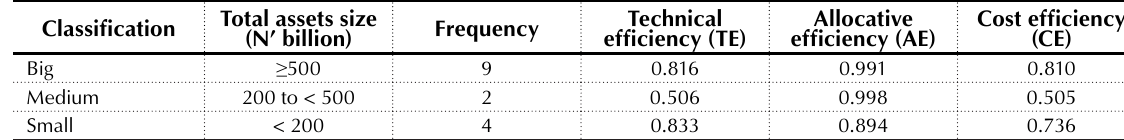
Source: authors’ computation.